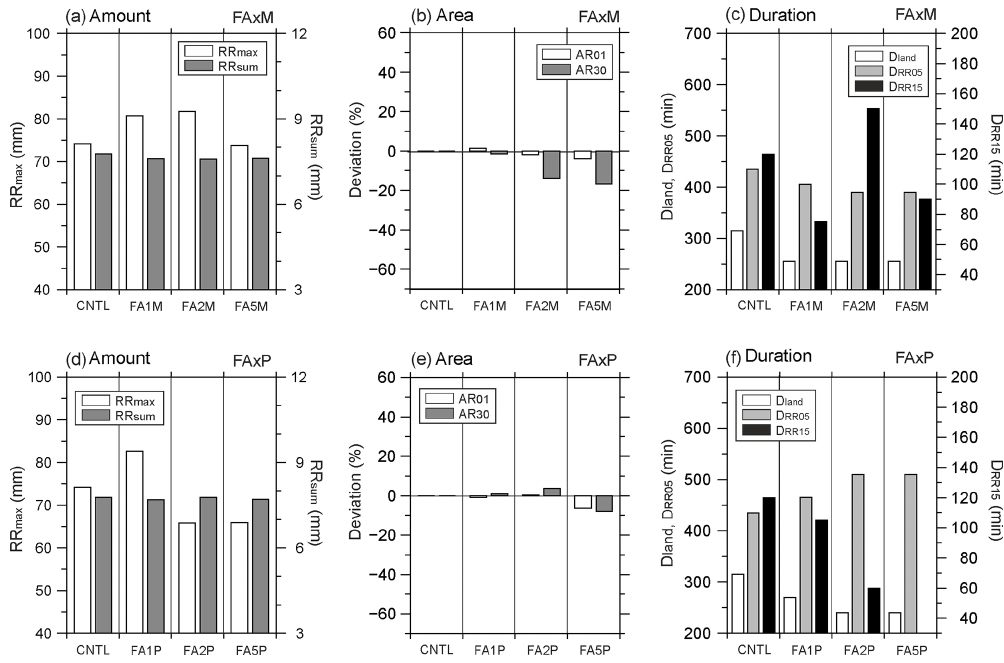
Figure 12. As Fig. 6 but for the CNTL, FA × M (a–c) , and FA × P (d–f) experiments.